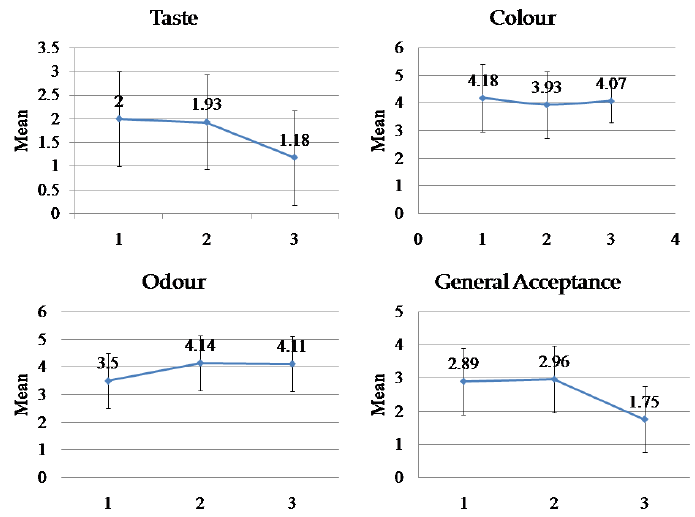
Figure 4. In vivo pediatric evaluation of Clarithromycin (CM) (125 mg/5 mL) suspensions. As the data were not normally distributed, the Kruskal–Wallis test was used to compare medians; the results of the three products are summarized in Table 2.